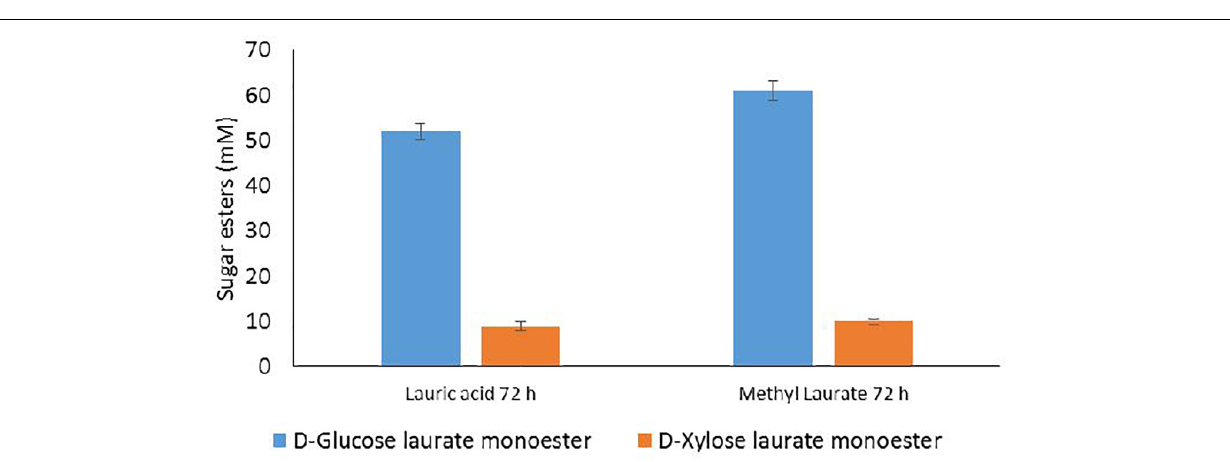
FIGURE 6 | HPLC quantification of D-glucose and D-xylose laurate esters recovered from acylation reactions performed with the lipase N435 in the presence of 100 mM D-glucose and D-xylose recovered from the aqueous phase of transglycosylation reaction and lauric acid or methyl laurate at 300 mM in 2M2B during 72 h. Error bars were obtained from triplicate